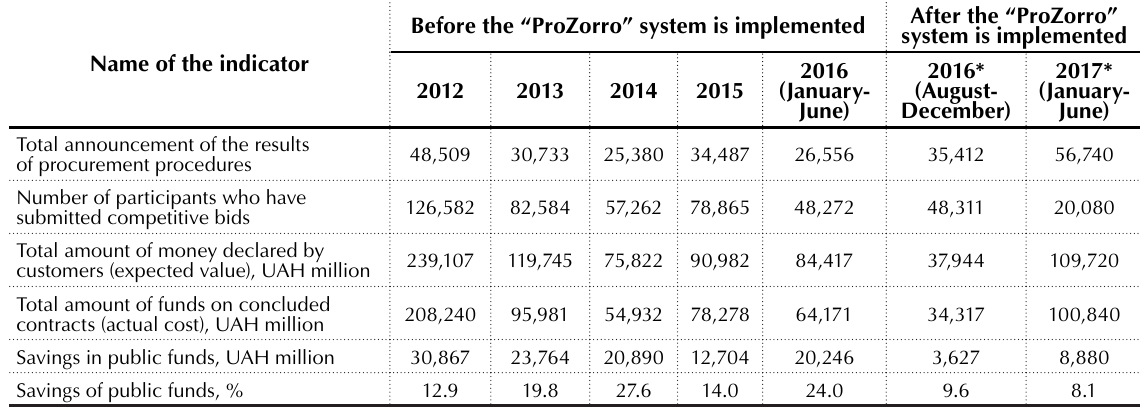
Table 1. Implementation of public procurement under the open bidding procedure in Ukraine during the period